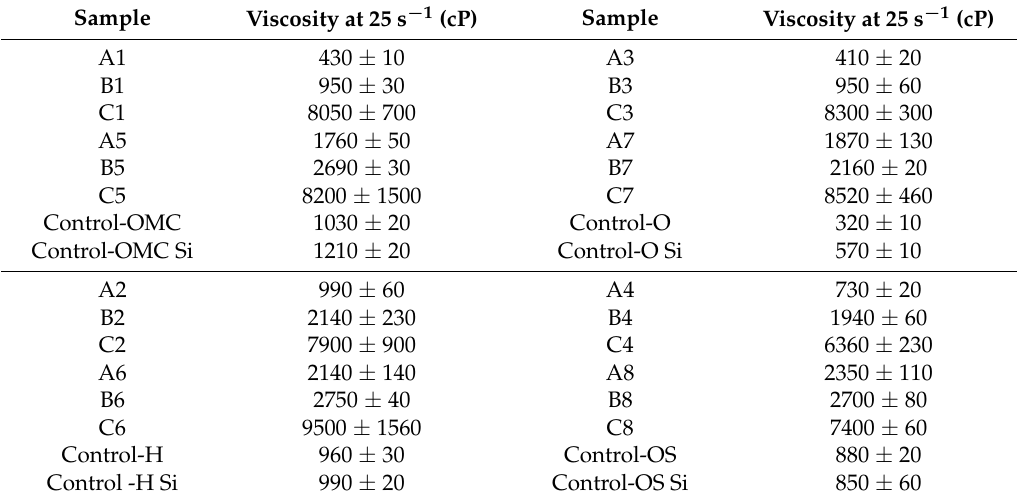
Table 5. Viscosity of the sunscreens at room temperature at 25 s − 1